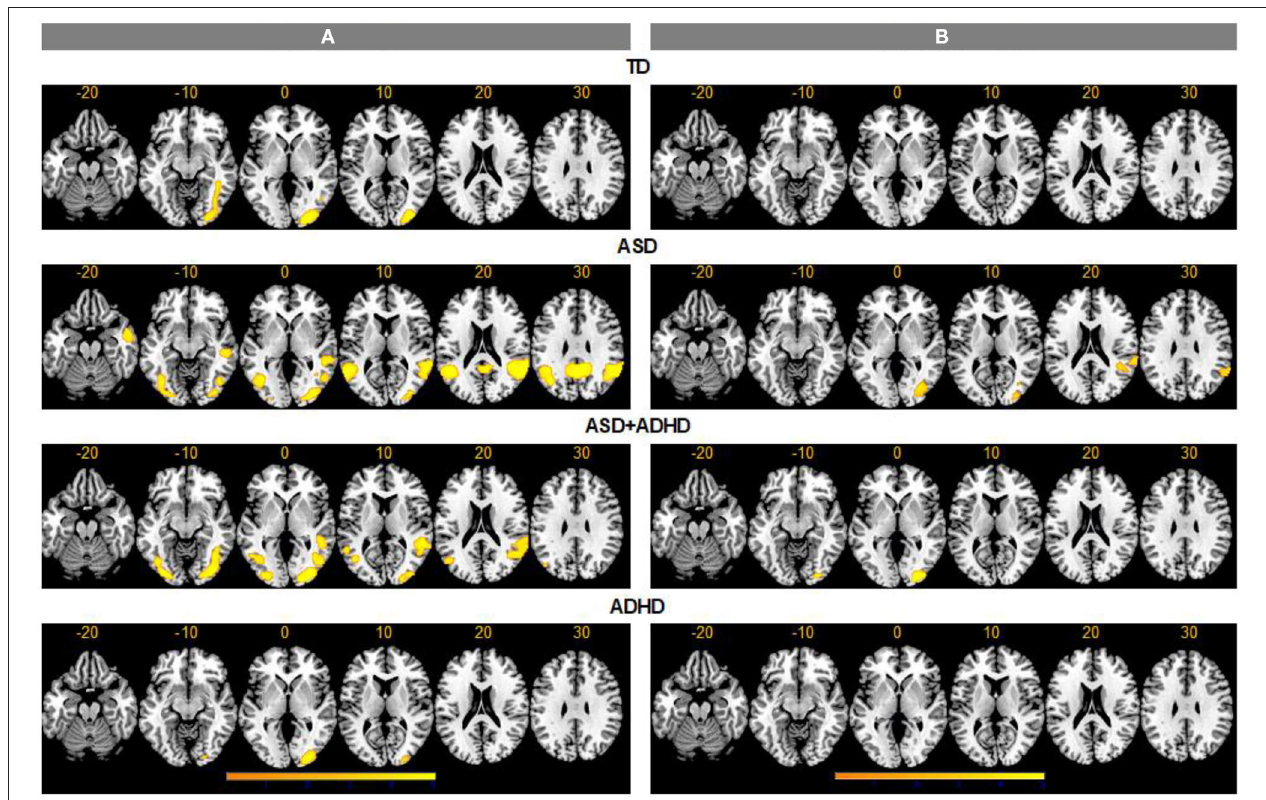
FIGURE 2 | Activation clusters for theory of mind (ToM) over random (RD) and goal-directed (GD) motion experimental conditions. TD, typical development; ASD, autism spectrum disorder; ADHD, attention-deficit/hyperactivity disorder. (A) ToM > RD, (B) ToM > GD.